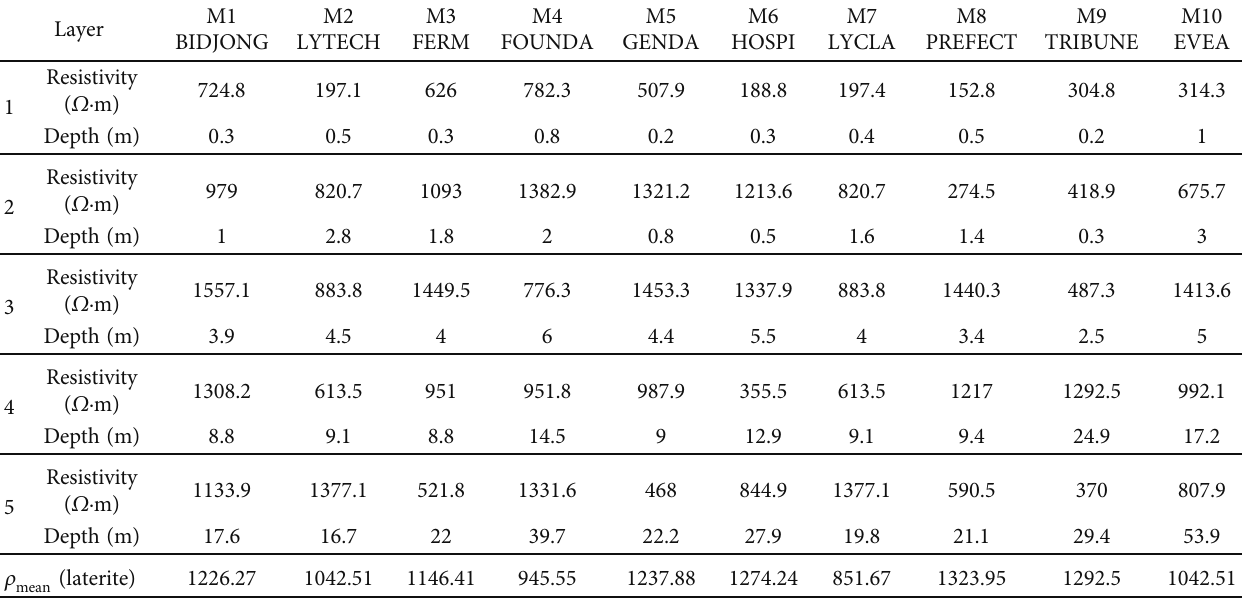
Table 3: Compiled VES data in the green belt zone.